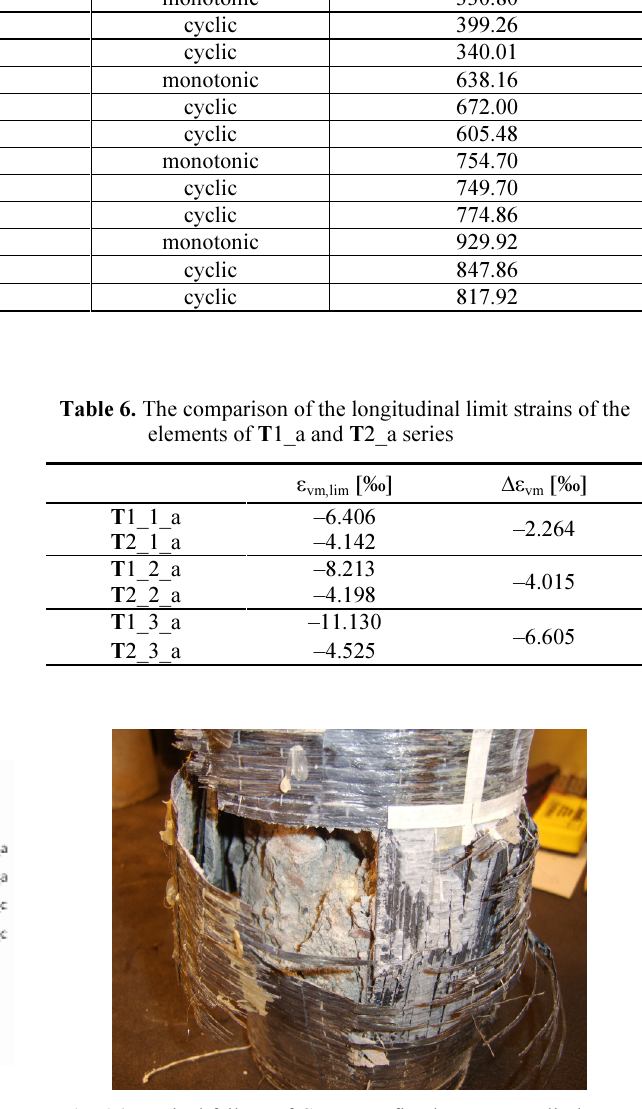
Fig. 16. Typical failure of CFRP confined concrete